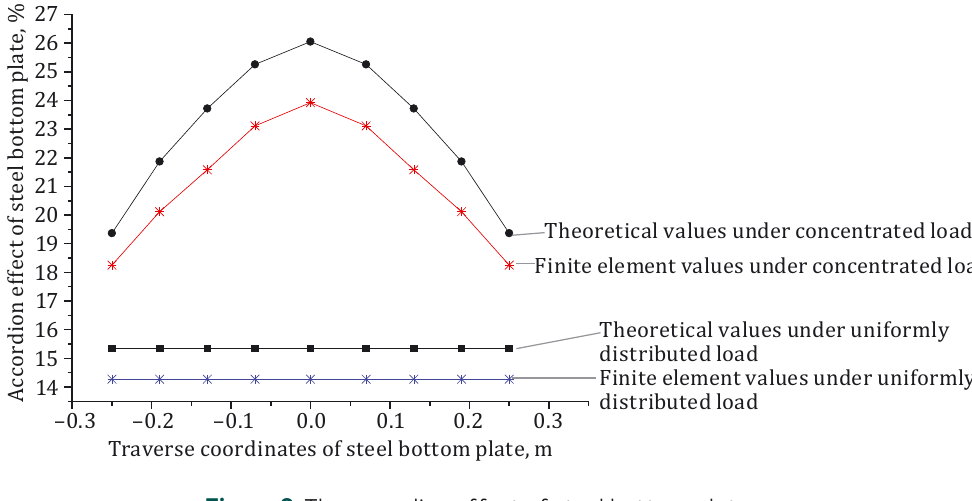
Figure 9. The accordion effect of steel bottom plate Traverse coordinates of steel bottom plate, m